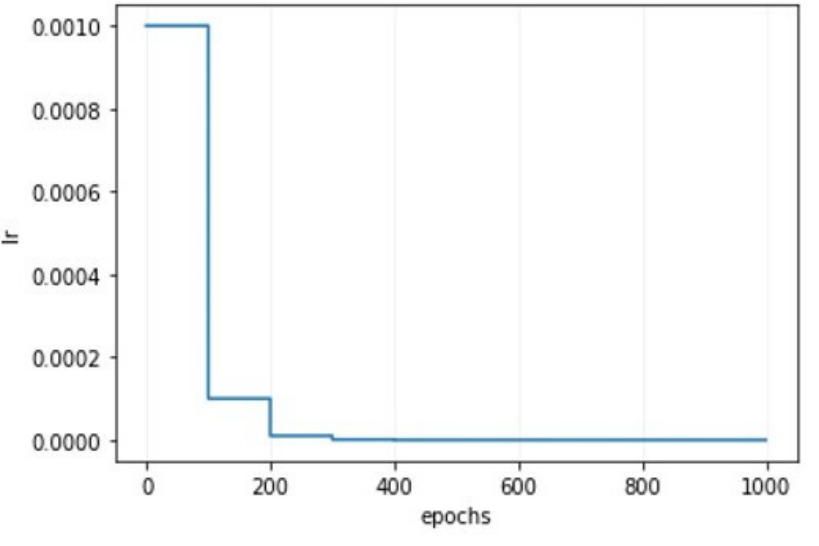
Figure 10. Learning rate with decay rate